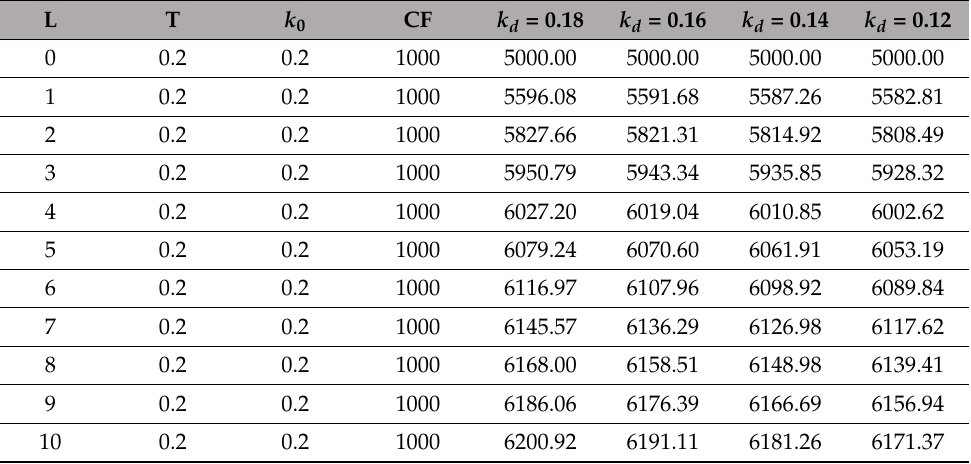
Table A7. Dependence of the company capitalization, V , on leverage level L at p = 4 and